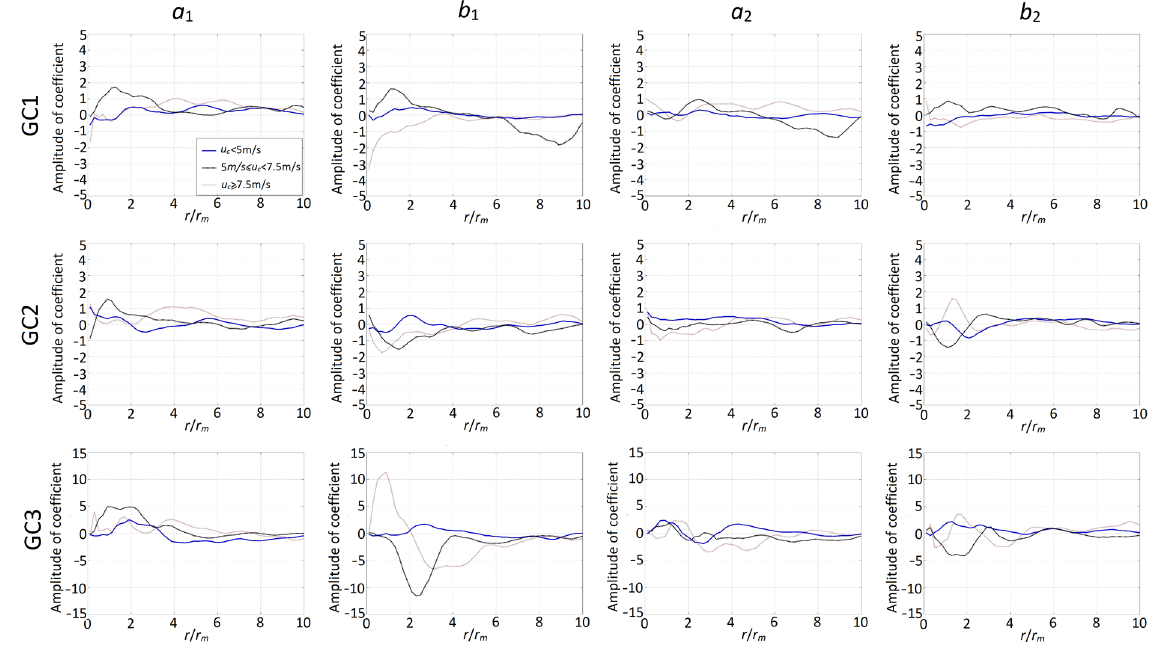
Figure 4. Coefficients for the asymmetric rainfall intensity field for Case 1. The first to third rows correspond to GC1 to GC3, respectively. a k ( r / r m ) and b k ( r / r m ) has units of mm/h, where k = 1 and 2.